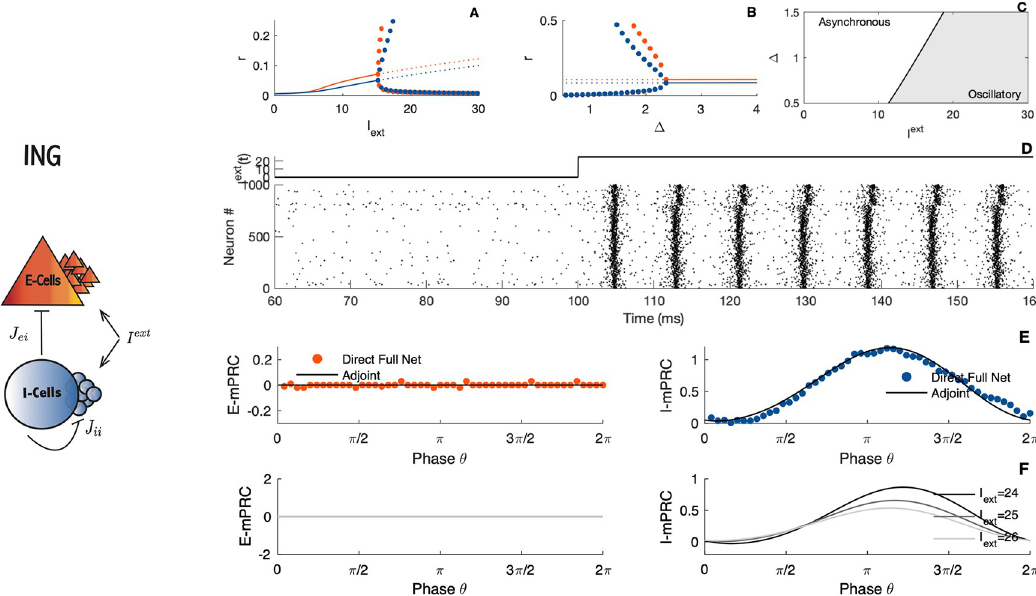
Fig 3. The ING interaction. Left panel: Schematic illustration of the ING (Interneuron Network Gamma) interaction. The parameters are as Fig 1, except that the extenal current I ext goes on both populations. Right panels: Nonlinear analysis of the The ING interaction. A-B) Bifurcation diagrams. The blue line, (respectively the red line), corresponds to the steady state of the inhibitory cells, (respectively the excitatory cells) while dots correspond to limit cycles. C) Stability region. D) The stimulus and corresponding raster plot of the spiking activity. E) Comparison between simulated and calculated mPRCs. The black line illustrates the analytical adjoint method while dots indicates direct perturbations of the full network. Red dots, perturbations are made on the E-cells, second row, with the blue dots, perturbations are made on the I-cells. F) PRC shape as a function of parameters obtained via the adjoint method for different values of the external current. Parameters: N 10; J ii = 15; J ie = 0; v th = 500; v r = − 500; panel A) Δ e = Δ i = 1; panel B) I ext = 25; panel D) Δ e = Δ i = 1; panel E-F) Δ e = Δ i = 1; I ext = 25, direct perturbations are made with a square wave current pulse (amplitude 5, duration